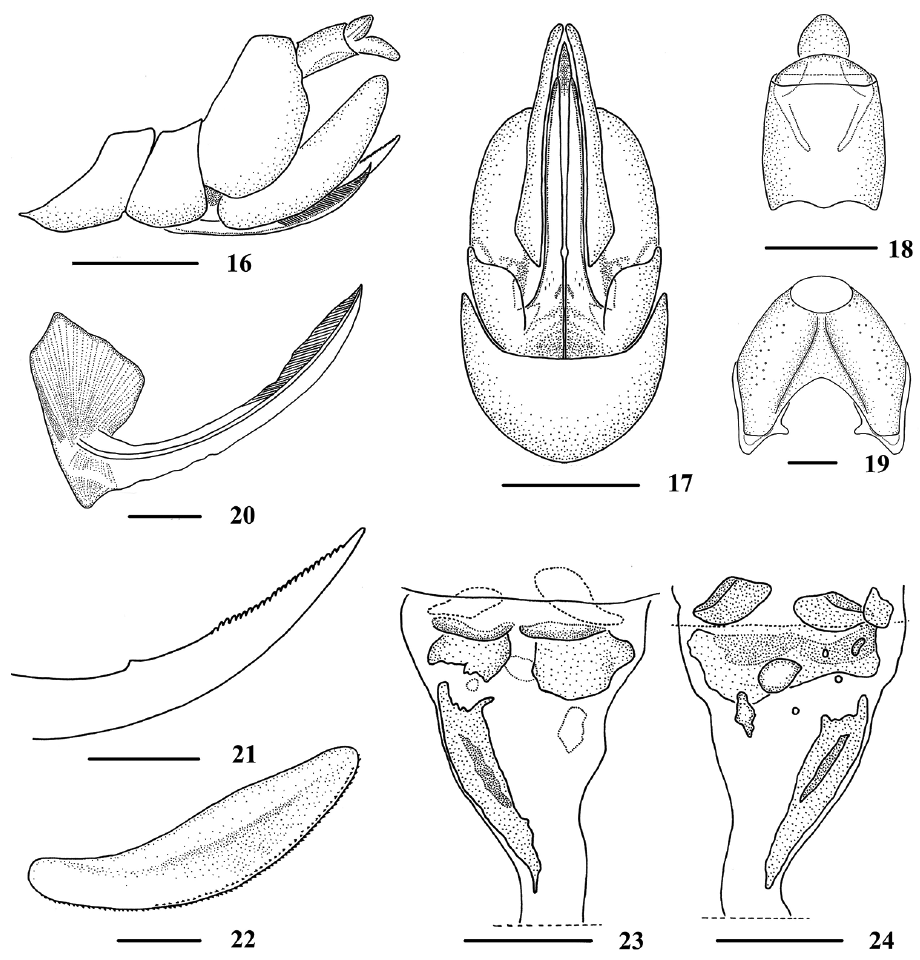
Figures 16–24. Neocarpia acutata sp. n., female 16 Genitalia, lateral view 17 Genitalia, ventral view 18 Anal segment, dorsal view 19 Pygofer, caudal view 20 Gonapophysis VIII and gonocoxa VIII, dorsal view 21 Gonapophysis IX, lateral view 22 Gonoplac, inner lateral view 23 Posterior vagina, ventral view 24 Posterior vagina, dorsal view. Scale bars: 0.5 mm ( 16–17 ); 0.2 mm ( 18–24 ). Female genitalia of N. acutata sp. n. is similar to N. bidentata Zhang & Chen, 2013, but differs in: (1) posterior vagina elongate, left side with two longitudinal scle- rites (in N. bidentata , posterior vagina relatively short, left side with one longitudinal sclerite); (2) each side of posterior vagina with a small sclerite near terminal in ventral view (in N. bidentata , posterior vagina with a wide sclerite medially and a small longi- tudinal sclerite on the left side near terminal in ventral